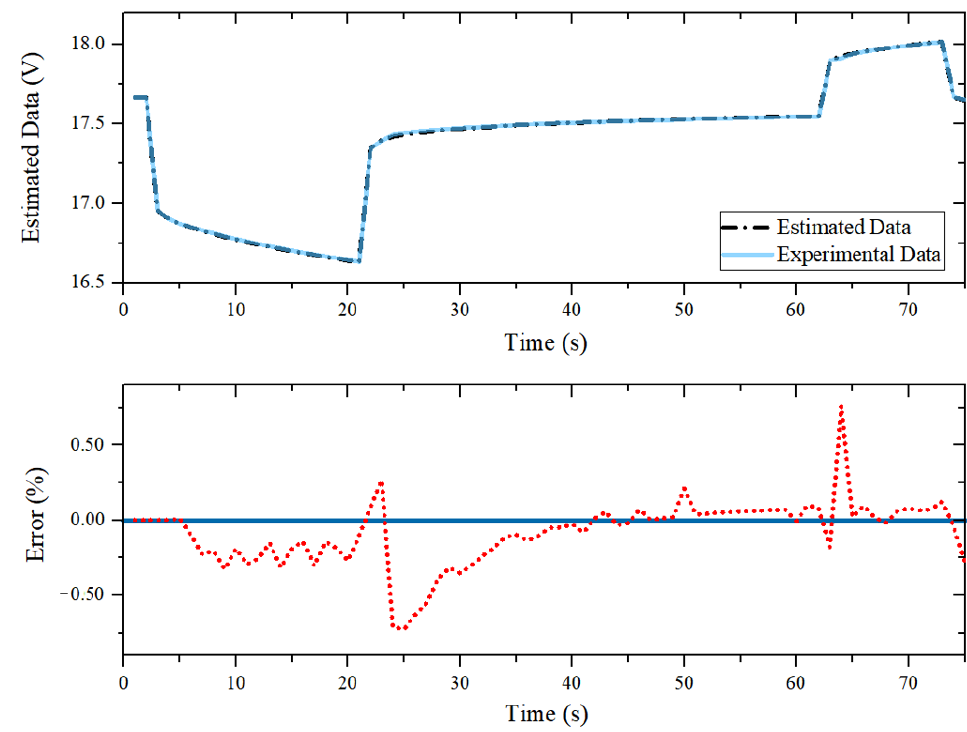
Figure 3. Identification results.